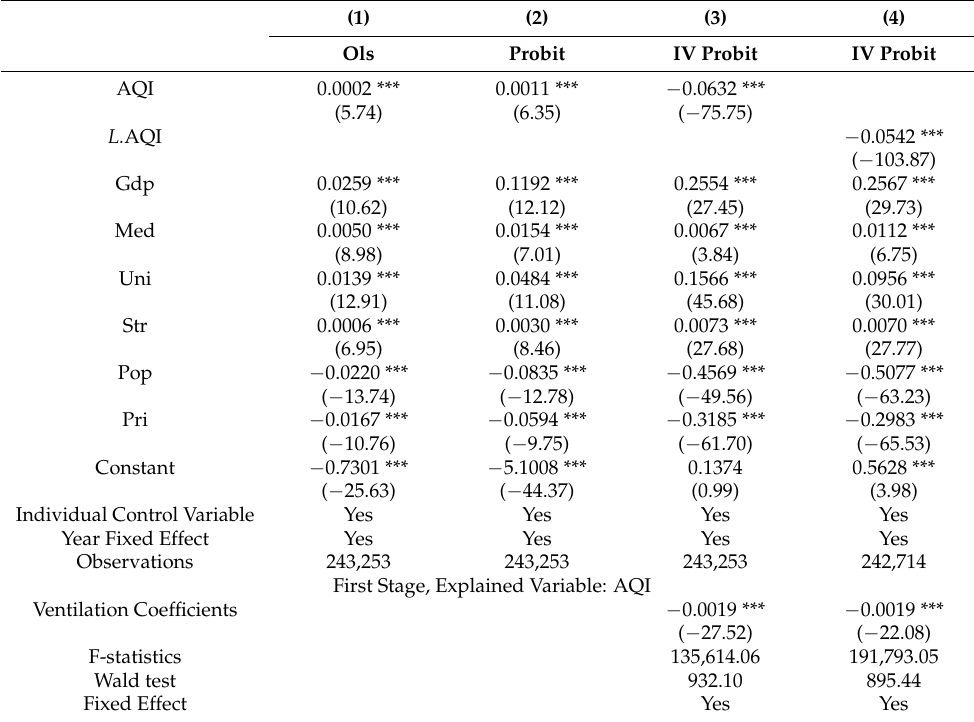
Table 2. The impact of air pollution on migrants’ settlement